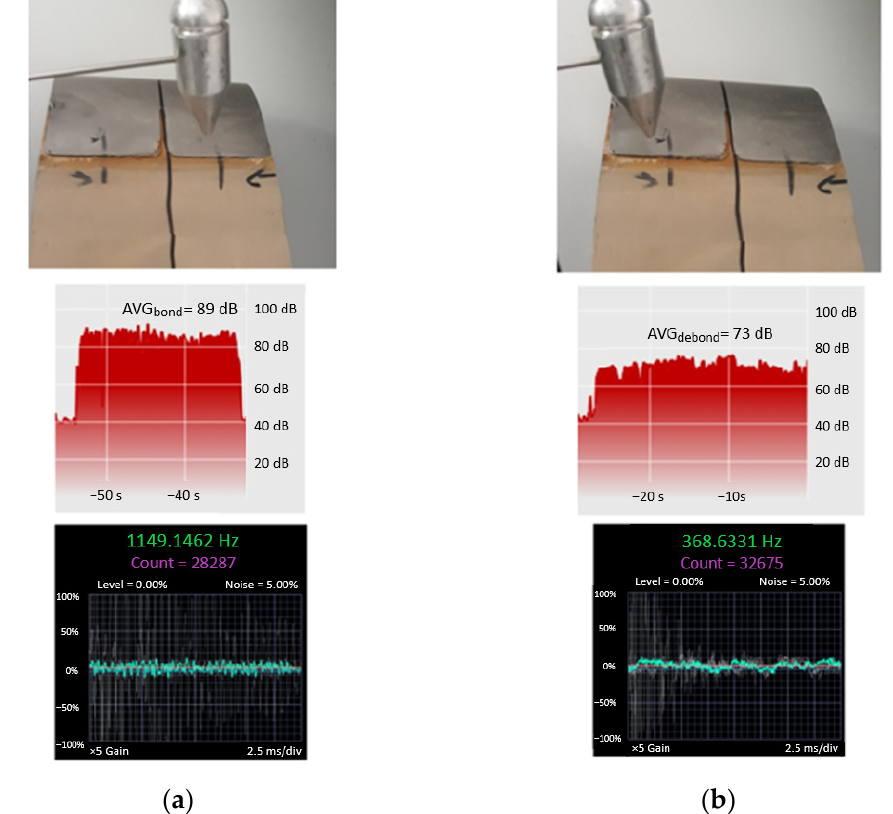
Figure 20. Tap-test of a reference sample with sound intensity and frequency measurement: ( a ) Shield bonded; ( b ) Shield disbonded.